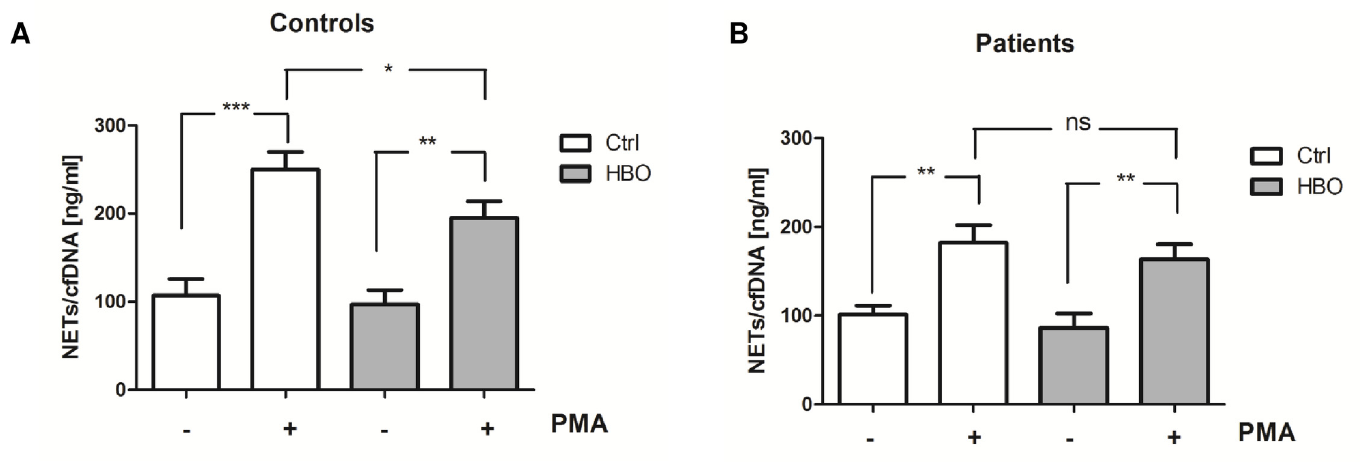
Fig 2. HBO reduces NETs release from neutrophils. Neutrophils from polytraumatized patients (Patients; n = 7) and healthy volunteers (Controls; n = 12) were exposed to HBO (HBO; 2.0 atm) for 120 min or cultured under normobaric and normoxic conditions (Ctrl). Then, cells were stimulated with PMA (20 nM) and incubated under cell culture conditions for 3 h. NETs / Cell-free DNA (cfDNA) in culture supernatants were quantified by Pico Green staining. * p < 0.05; ** p < 0.01; *** p < 0.001; ns = not significant